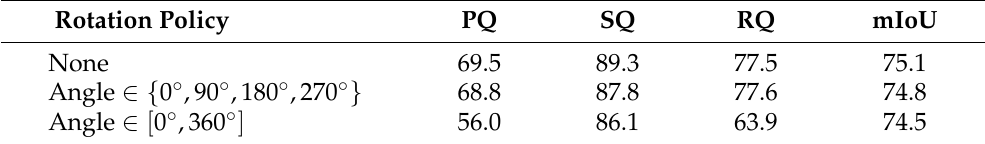
Table 2. Validation of rotation for data augmentation on the validation set of the BSB Aerial dataset. Rotation